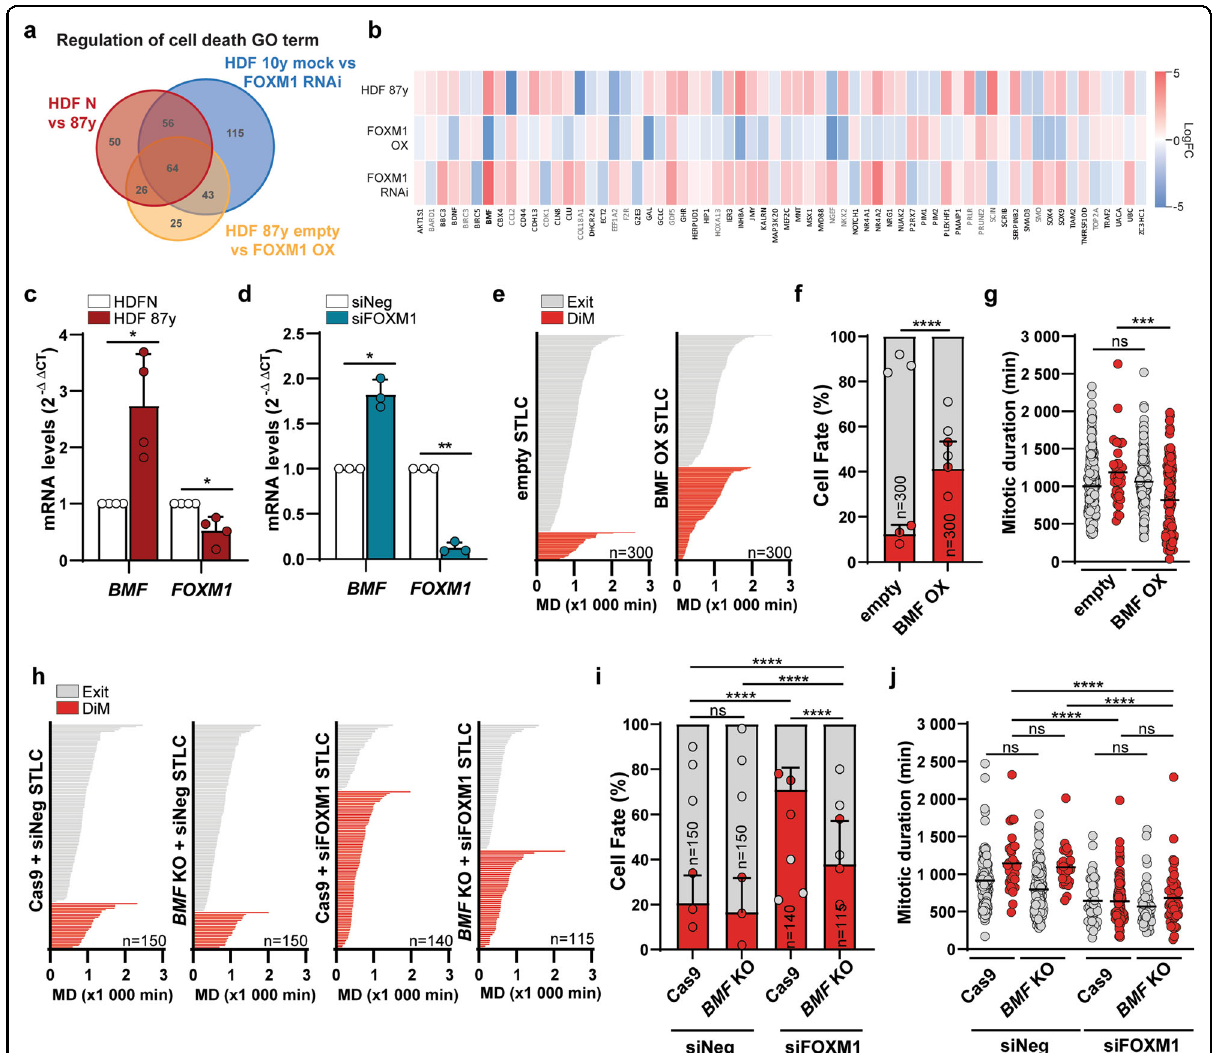
Fig. 2 BMF upregulation under low FOXM1 levels accounts for the shift towards DiM. a Venn diagram of the cell death GO term genes (DAVID Functional Annotation 52 ), found signi fi cantly altered in the RNA-seq data sets of N vs. 87 y, 10 y mock vs. FOXM1 RNAi, and 87 y empty vs. FOXM1- overexpressing mitotic HDFs 27 . b Heatmap of the 64 overlapping cell death genes shown in a . FC, fold change. c BMF and FOXM1 transcript levels in mitotic cells from N vs. 87 y HDFs. d BMF and FOXM1 transcript levels in mitotic cells from siNeg vs. siFOXM1-depleted neonatal HDFs. e Individual cell fate pro fi ling of control (empty vector) ( n = 300) or BMF-overexpressing neonatal HDFs ( n = 300) treated with 5 µM STLC. MD, mitotic duration. f Cell fate percentage of the experiments described in e . g Mitotic duration of the individual cell fates shown in e . h Individual cell fate pro fi ling of CRISPR/ Cas9-edited control (Cas9) or BMF ( BMF KO) HDFs, depleted with Neg or FOXM1 siRNAs, and treated with 5 µM STLC. MD, mitotic duration. n = cell number. i Cell fate percentage of the experiments described in h . j Mitotic duration of the individual cell fates shown in h . Data information: In c , d data are mean ± S.D. from n = 4 and n = 3 independent experiments; * p ≤ 0.05, ** p ≤ 0.01 (two-tailed paired t test). In f , i data are mean ± S.D. of n = 3 independent experiments; **** p ≤ 0.0001 (two-tailed χ 2 ). In g values are mean; *** p ≤ 0.001 (two-tailed Mann – Whitney test). In j values are